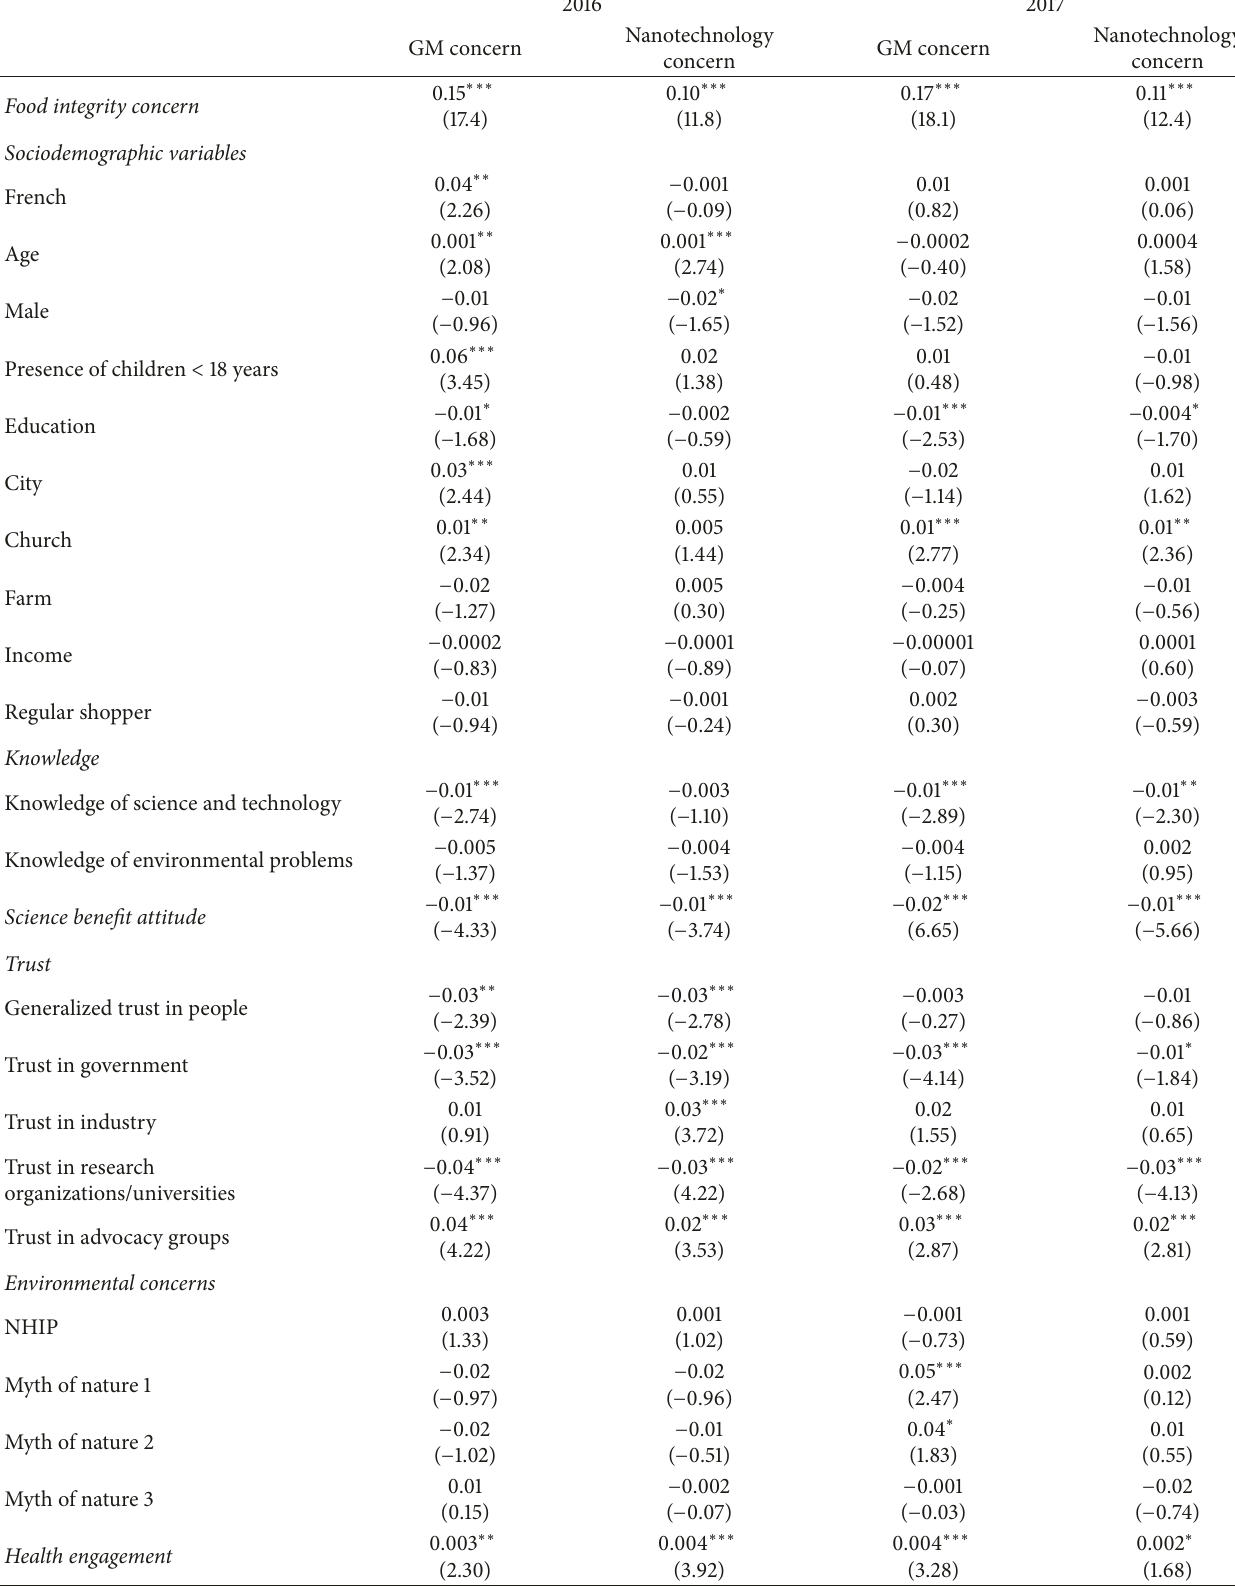
Table 6: Marginal effects for concerns about food integrity, GM, and